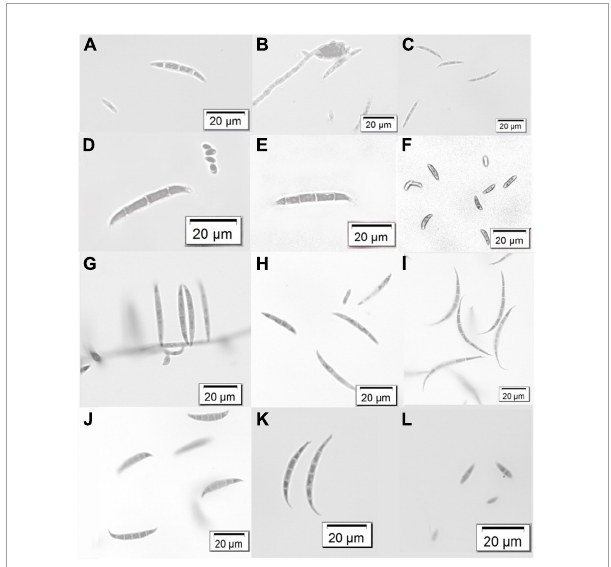
FIGURE3 Variation in macroconidium structures and some microconidia of the identified Fusarium species complexes from the GGHNP. FOSC (PPRI 26304) (A–C) , FSSC (PPRI 25492) (D,E) , FFSC (PPRI 27410) (F–H) , FIESC (PPRI 27406) (I) , FSAMSC (PPRI 27530) (J) , FCSC (PPRI 26282) (K,L) . Images were visualised using a light microscope at 40X magnification.